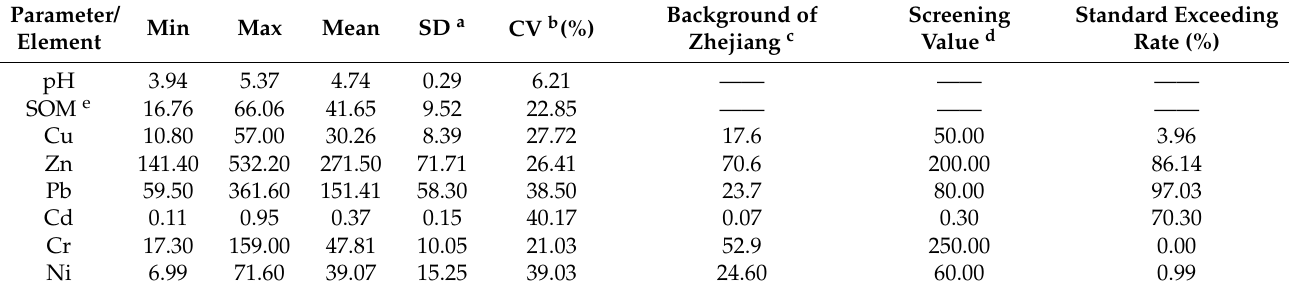
Table 1. Descriptive statistical analysis of soil heavy metals and soil properties (mg · kg − 1